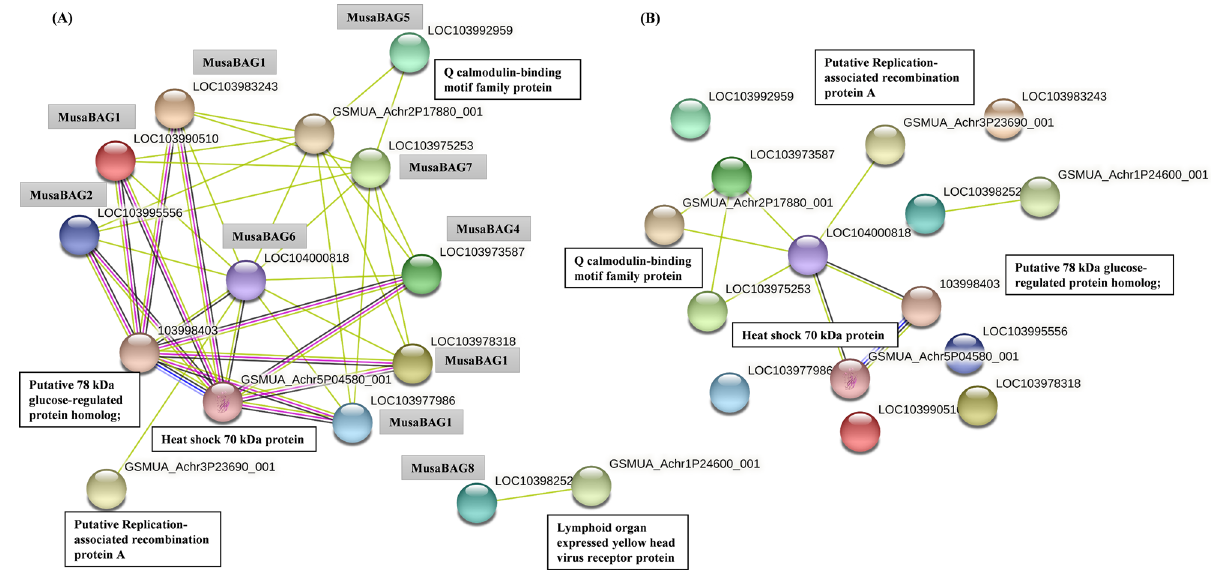
Figure 8. Protein–protein interaction network of MusaBAG proteins. The network was generated using STRING version 11.0, where each node represents a protein and each connecting line represents an interaction. The green line indicates interaction established through textmining, blue indicates co-occurrence of the proteins whereas pink link denotes interaction established through experimental evidence with moderate ( A , 0.400) and high ( B , 0.700) confidence